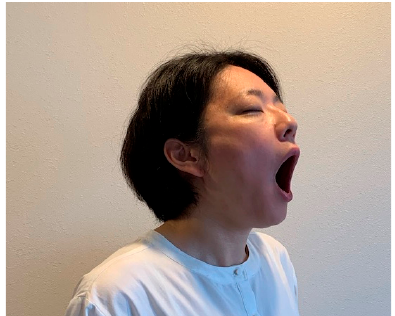
Figure 2. Jaw-opening exercise without pain group (JE w/o pain group): the participants performed the jaw-opening exercise without using their hands, by themselves. The opened position was main- tained for 10 s.